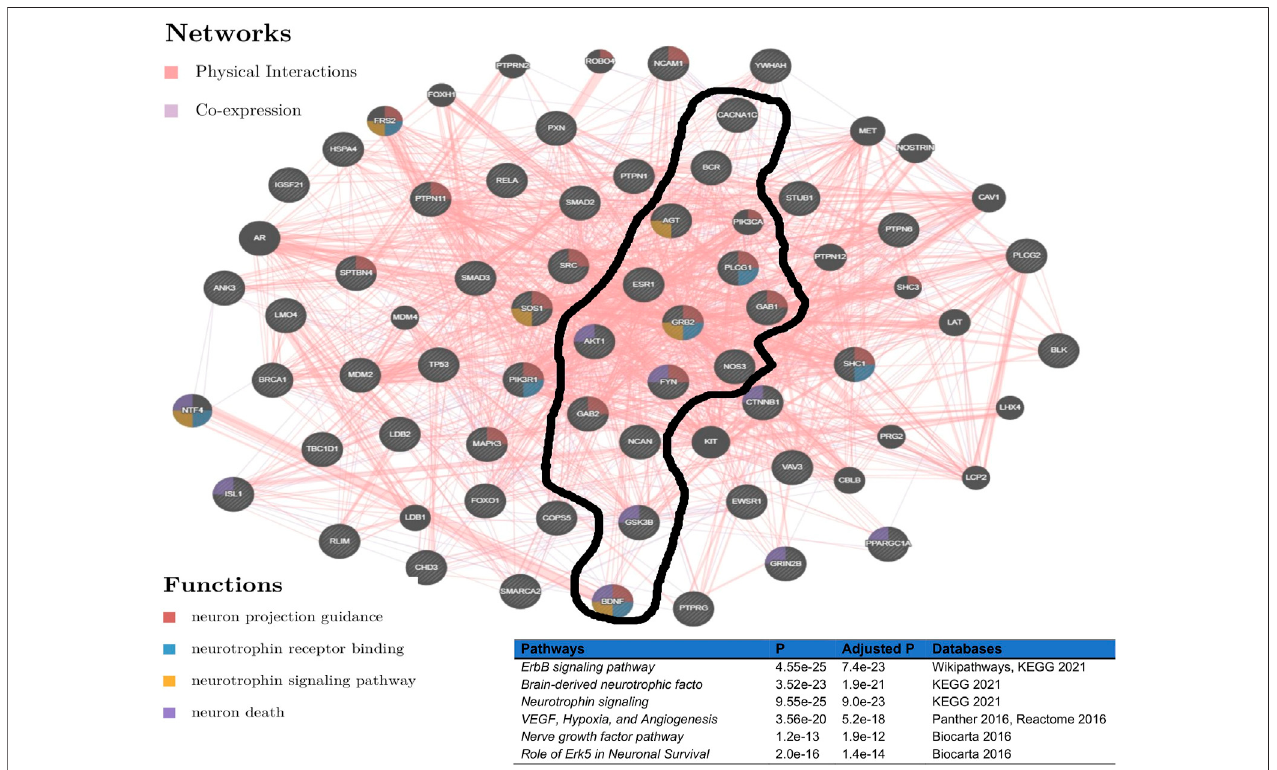
FIGURE4 | Network reconstructedfrom genesin Figure 3 , based on physical and co-expressed interactionsobtainedGeneMania Franz et al.(2018) and thetop pathways of the reconstructed network from Figure 3 obtained from various pathways databases in Enrichr Kuleshov et al.